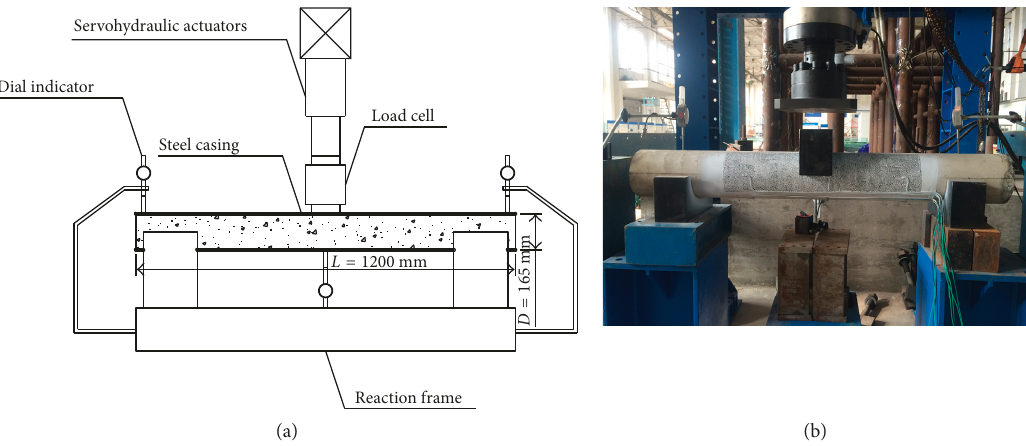
Figure 2: Test setup and instrumentation of specimens. (a) General view. (b) Photograph of loading device.